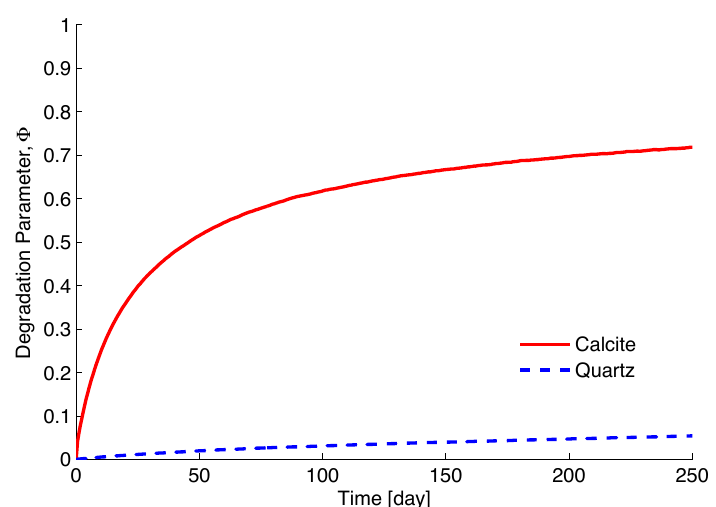
Figure 5. Simulation of the averaged degradation